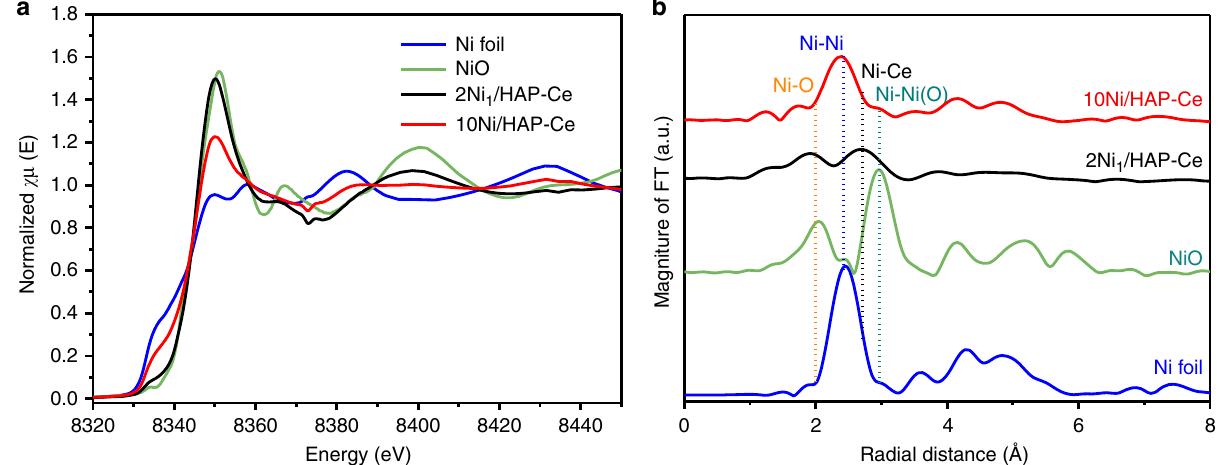
Fig. 2 X-ray adsorption spectroscopy study of Ni/HAP-Ce catalysts. a Ni K-edge XANES spectra of 500 °C reduced HAP-Ce supported Ni catalysts and reference samples, and b corresponding phase shift corrected k 2 -weighted Fourier